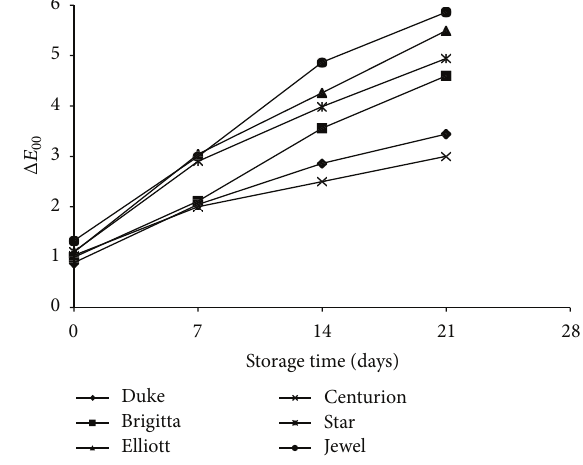
Figure 5: Color change (Δ𝐸 00 ) of different cultivars over storage time at 4 ∘ C and 90%